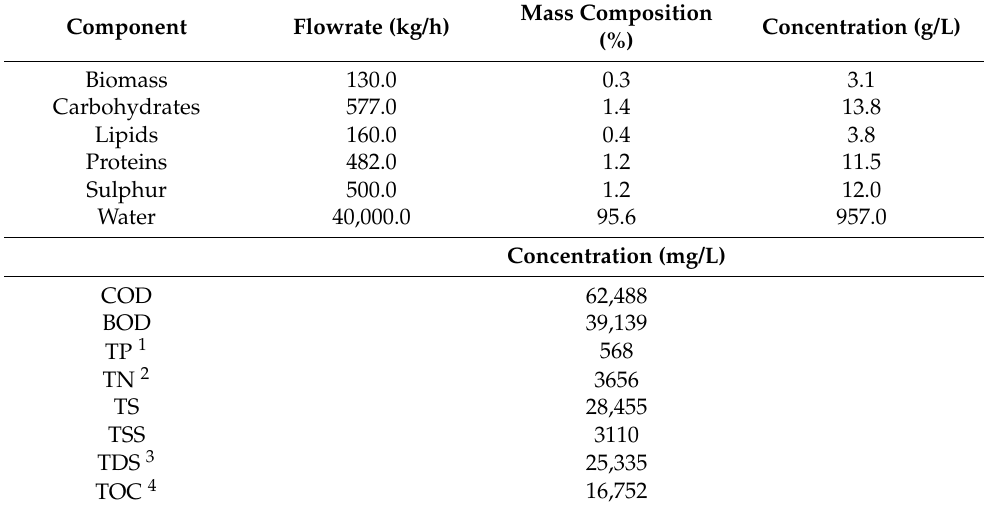
Table 1. Feed composition for POME